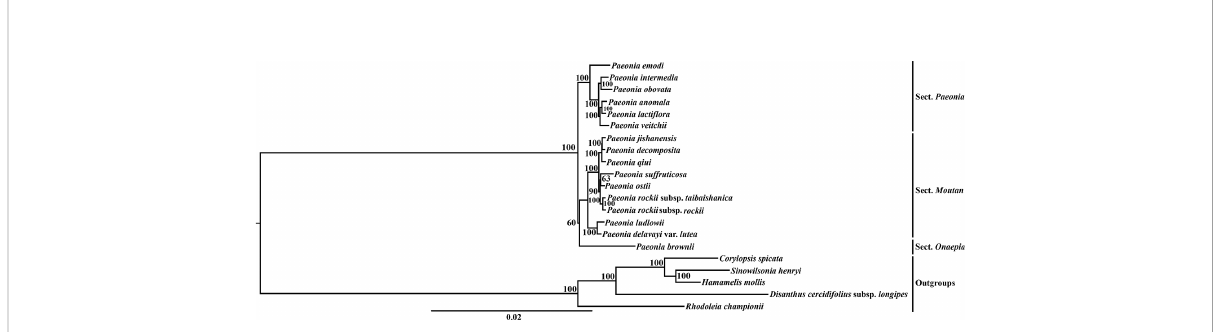
FIGURE 2 The maximum likelihood (ML) tree of Paeoniaceae inferred from the whole plastome data set. Numbers at nodes correspond to ML bootstrap percentages (100 replicates, only values greater than 50% are shown).